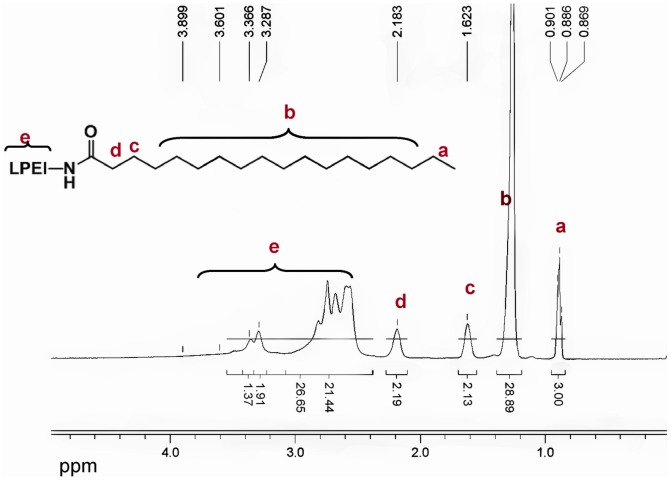

1H NMR spectrum of Stearic-PEI.(CDCl3), δ (ppm) 0.86–0.89 (t, -CH2CH2(CH2)15CH3), 1.25 (br, -CH2CH2(CH2)15CH3), 1.62 (br, -CH2CH2(CH2)9CH3), 2.18 (br, -CH2CH2(CH2)9CH3), 2.39–3.3 (m, -CH2CH2NH-, -CH2CH2N-, -CH2CH2NHCO-, -CH2CH2NHCO-).